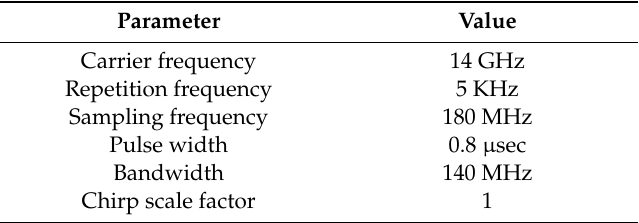
Table 3. SAR system